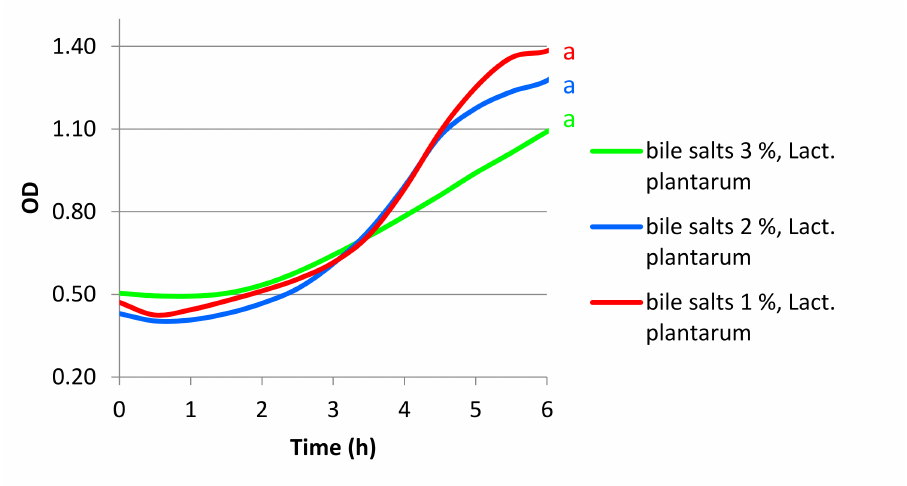
Figure 5. Changes in the optical density during culture of Lb. plantarum from commercial probiotic strains in the food matrix under simulated condition of the gastric and gastrointestinal passage; in this case it was only one homologous group signed a ( p < 0.05). Each homogeneous group’s corresponding pH was marked the same color as pH line